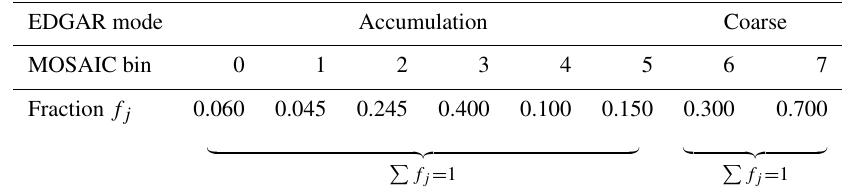
Table 2. Assignment of EDGAR particulate fluxes to MOSAIC bins. Table 3. Assignment of EDGAR particulate fluxes to MOSAIC bins.